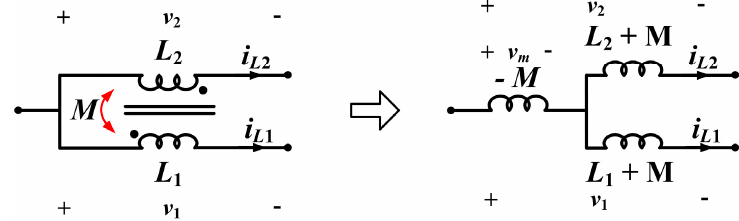
Figure 1. The circuit structure of the proposed micro-inverter.